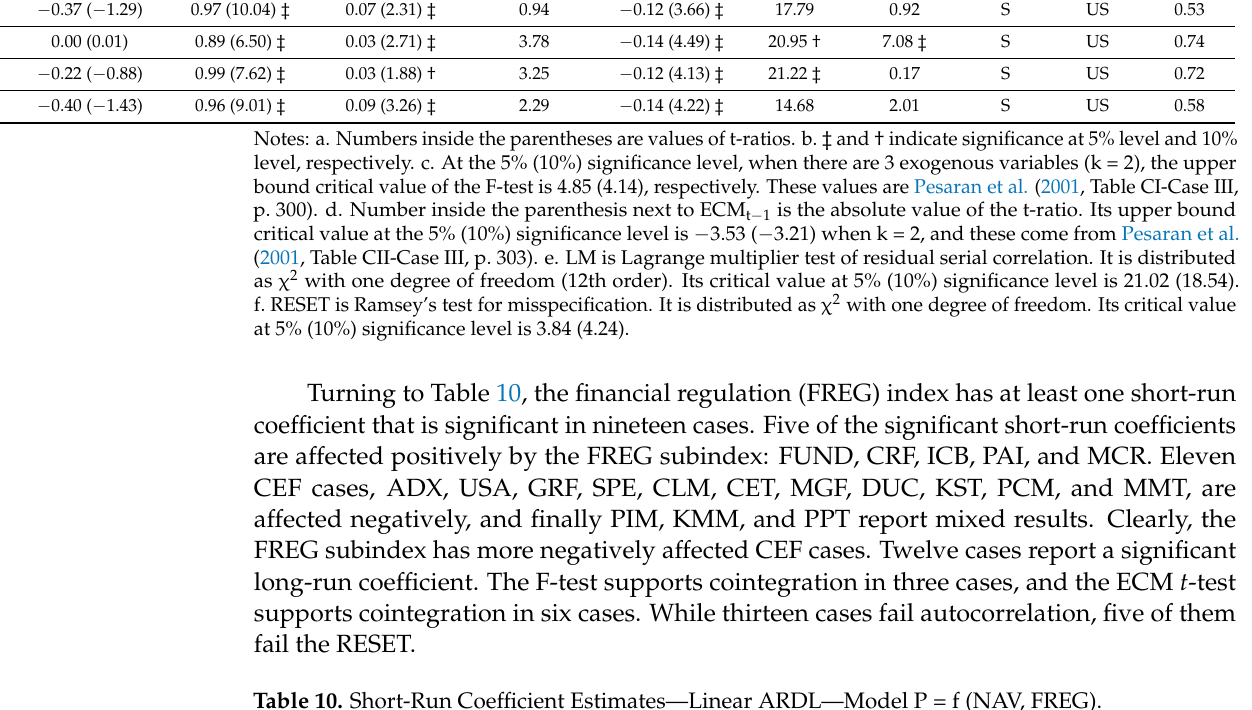
Table 10. Short-Run Coefficient Estimates—Linear ARDL—Model P = f (NAV,